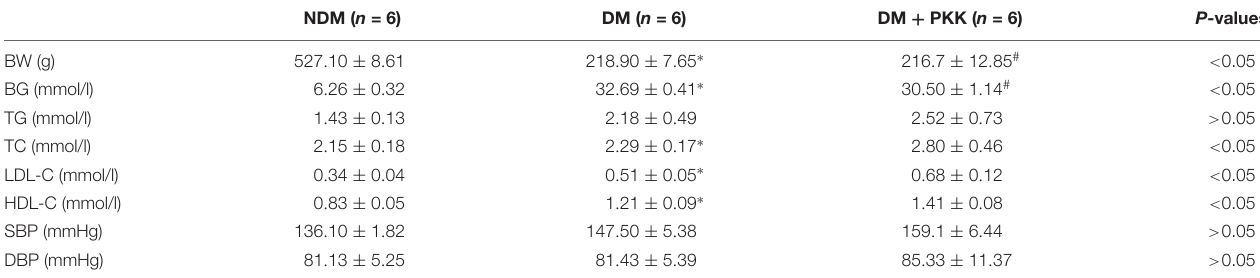
TABLE 2 | Basic characteristics of SD